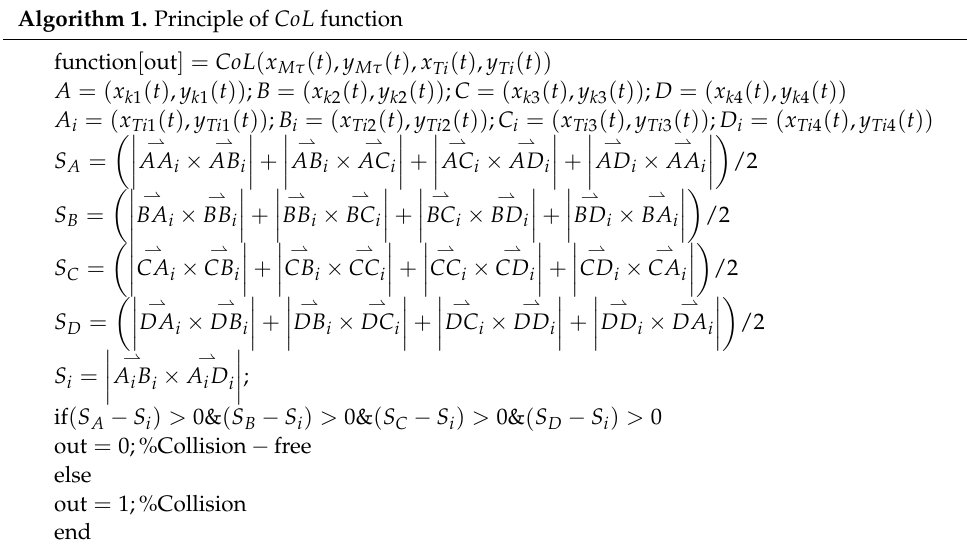
τ is the end time of i